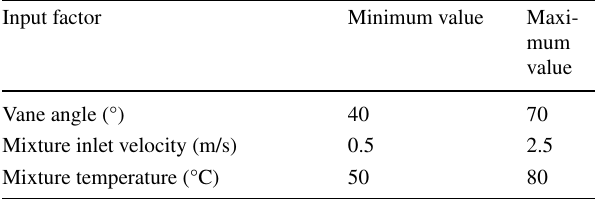
Table 1 Minimum and maximum values of factors input to